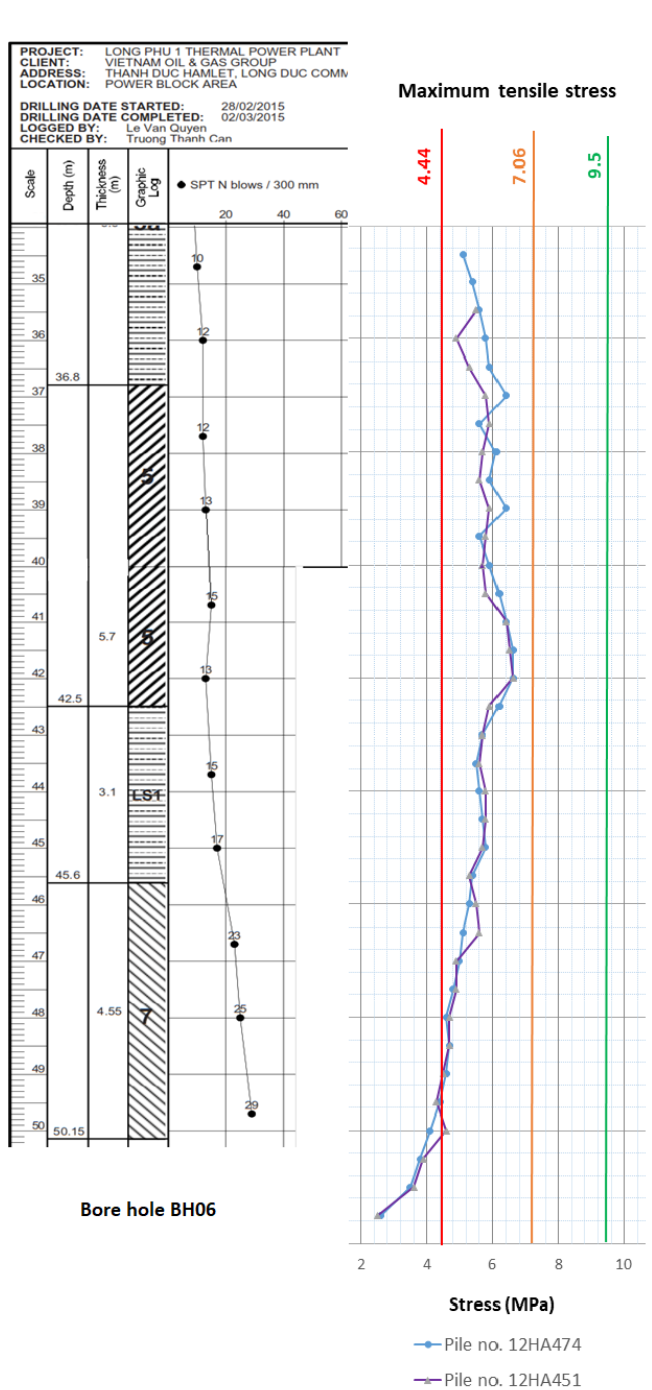
Figure 6. Stress Measurements, Last Segments of Piles No. 12HA 474 and 12HA